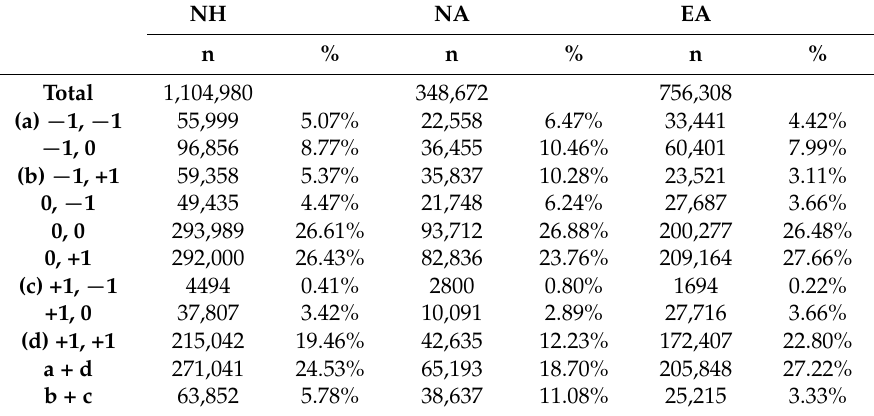
Figure 3. Comparison of trends in LOS and GSI 1982–2013. − 1: denotes significant negative trends, +1: significant positive trends, 0: non-significant trends ( p = 0.1). Table 1. Comparison of LOS and GSI time series trends during 1982–2013 (Figure 3) at hemispheric and continental scales. The first mentioned trend represents LOS and the second trend denotes GSI ( p = 0.1). (a): converging trends type 2, (b): diverging trends type 2, (c): diverging trends type 1, (d): converging trends type 1 (a + d: consistent significant positive trends in LOS and GSI, b + c: opposite significant trends in LOS and GSI).